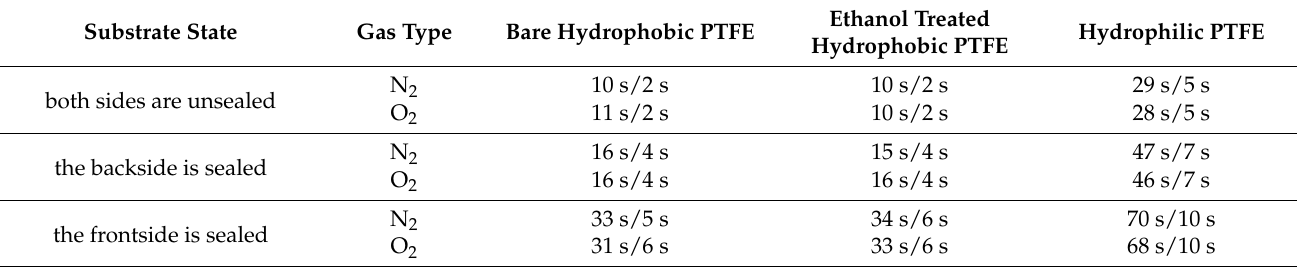
Table 1. Dynamic characteristics of the sensors using N 2 and O